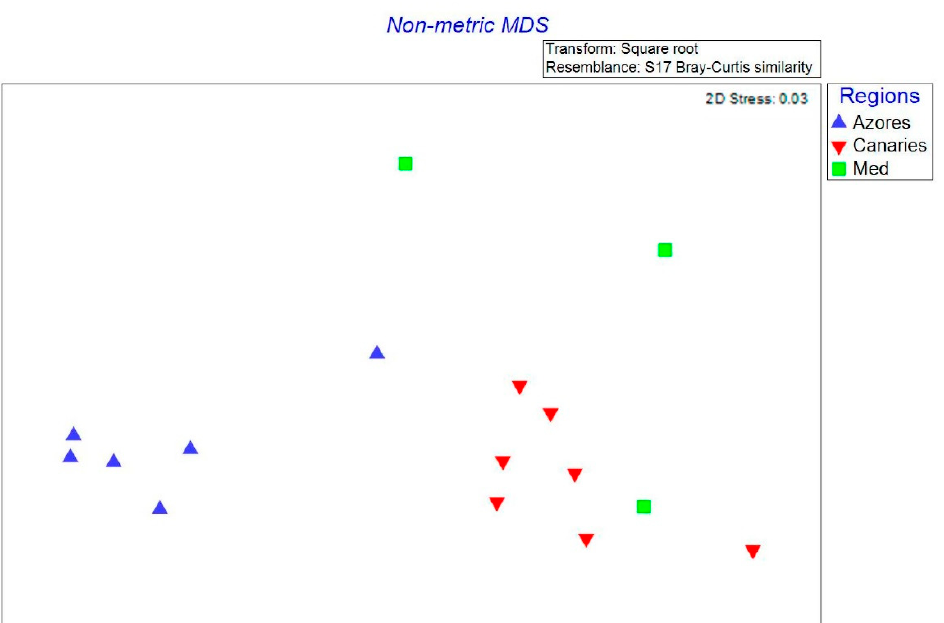
Figure 6. Cadmium content (mean mg kg − 1 dry weight) according to several taxa. Green columns represent Azores studies, orange columns represent studies performed in the Canaries, and black columns represent values in wet weight. Red lines represent maximum levels of cadmium, in wet weight, according to Regulation (EC) No 1881/2006: ( a ) 0.05 (seaweeds), ( b ) 0.5 (crustaceans), ( c ) 1 (mollusks), and ( d ) 0.05 (fishes).